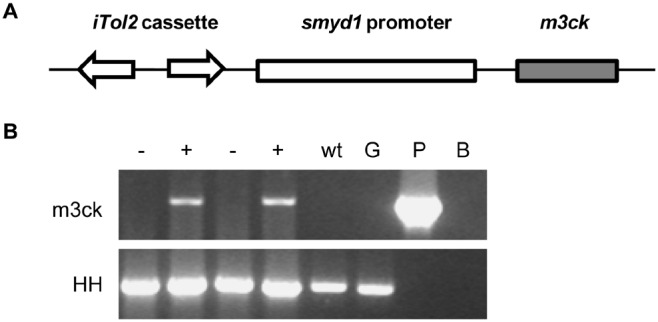
The transgenic cassette and identification of transgenic zebrafish.A. Design of the transgenic cassette. m3ck was driven by the skeletal muscle-specific promoter smyd1 and the iTol2 cassette was introduced for germline transgenes. B. Identification of transgenic zebrafish by PCR with m3ck primers. HH-F/R primers derived from tiggy winkle hedgehog exon 3 were used as control primers. −, non-transgenic fish; +, transgenic fish; wt, embryo of wild-type fish; G, genomic DNA of wild-type zebrafish; P, the transgenic plasmid iTol2-smyd1-m3ck as positive control; B, blank control.